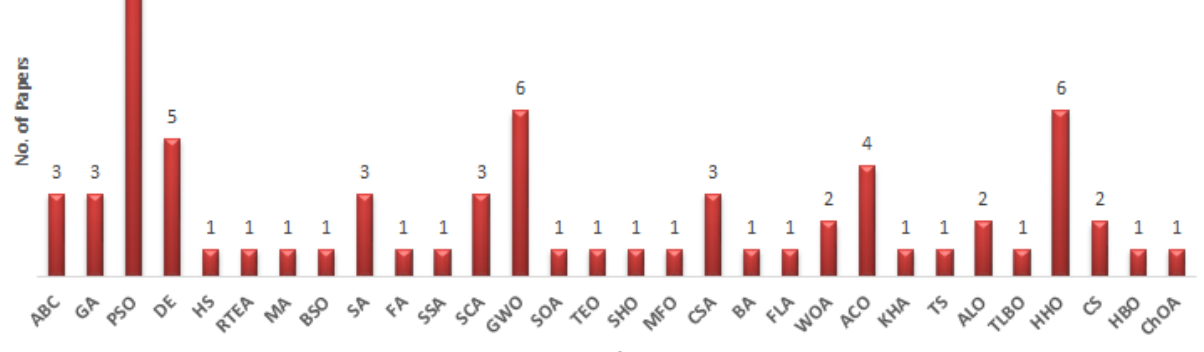
Figure 4. Number of papers per